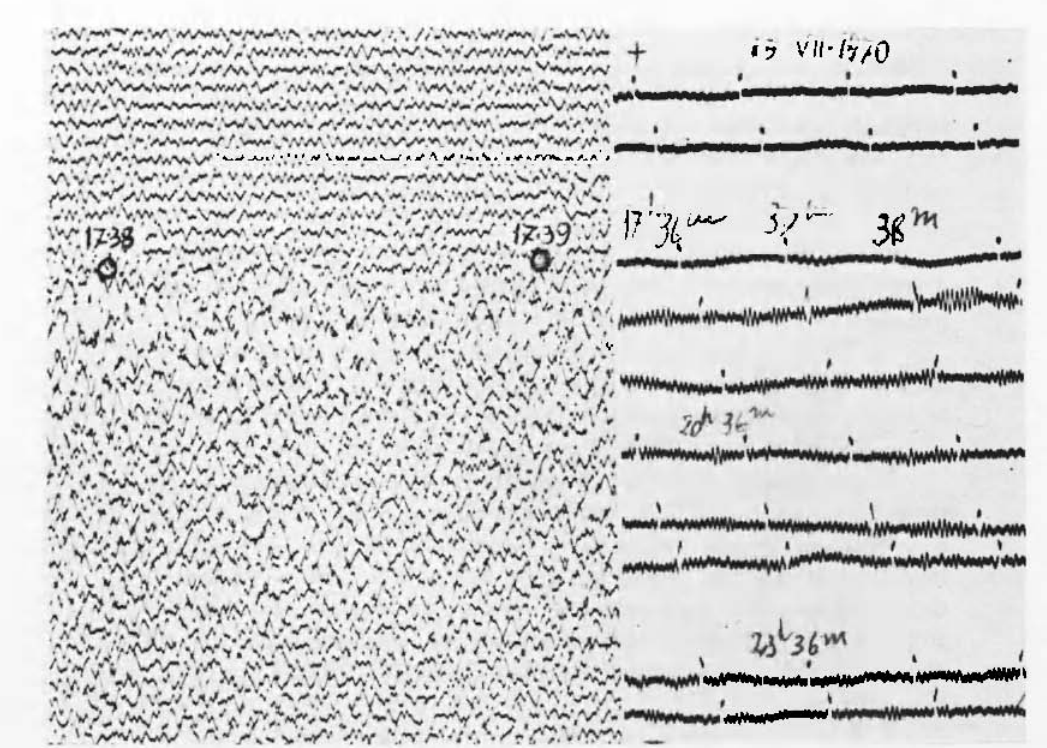
Fig. 19 - Registrazione ,lei mkroKiHmi, a.~Hol'iati allmn~ito del ciclone del 15.Vll,1970 sul golfo di Venezia, oaenuta a 'l'rieHte. A ~inislra figura la registrazione fornita